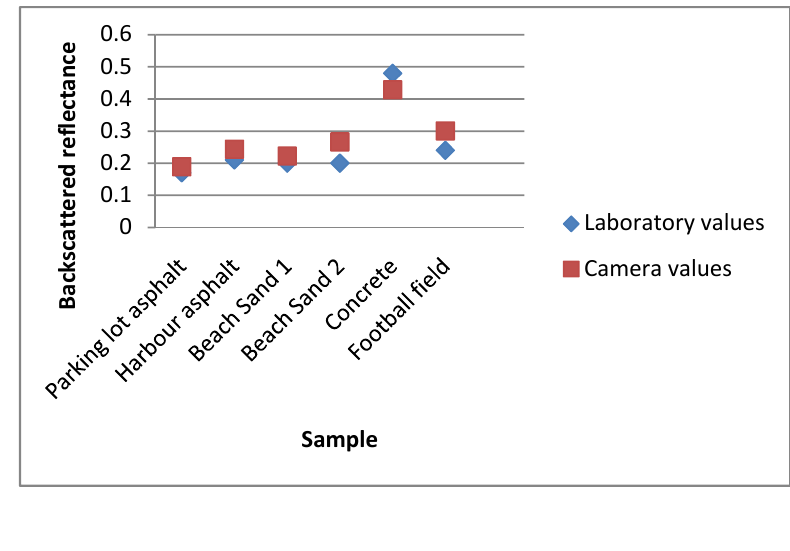
Figure 9. NIR camera results compared to the laser backscatter values of the field